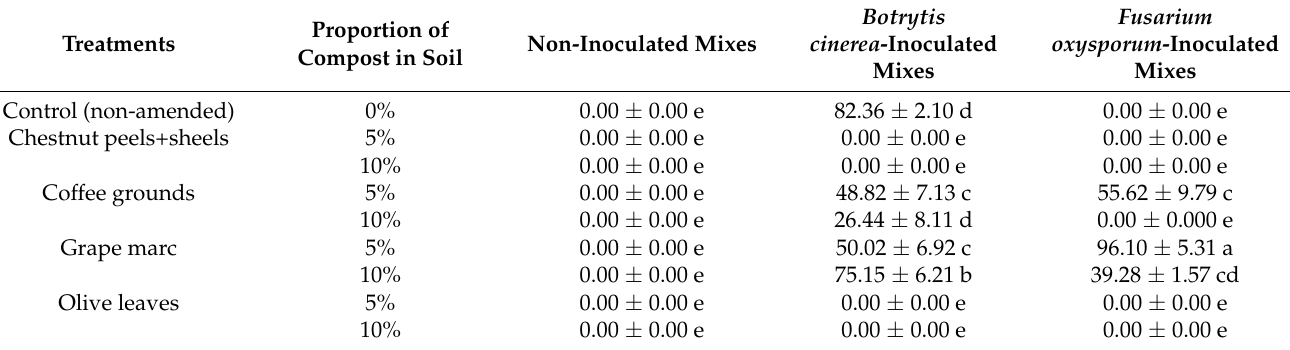
Table 1. Disease incidence of (a) gray mold and (b) Fusarium wilt in lettuce plants grown on soil/compost mixes inoculated with B. cinerea and F. oxysporum . The composts were incorporated into soils at proportions of 5% and 10% (weight basis). Control treatments consisted of non-amended Scheme 100. Different letters in a column or a row indicate significant differences among means ( p < 0.05; ANOVA/Tukey’s